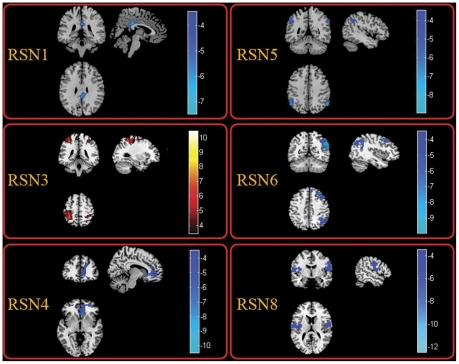
Two-sample t-tests results of the eight RSNs between MPE and TLE (P<0.05 corrected by FDR).The warm and cold colors indicate the brain regions with significantly increased and decreased functional connectivity in MPE compared with TLE, respectively. The left side of the image corresponds to the left side of the brain.